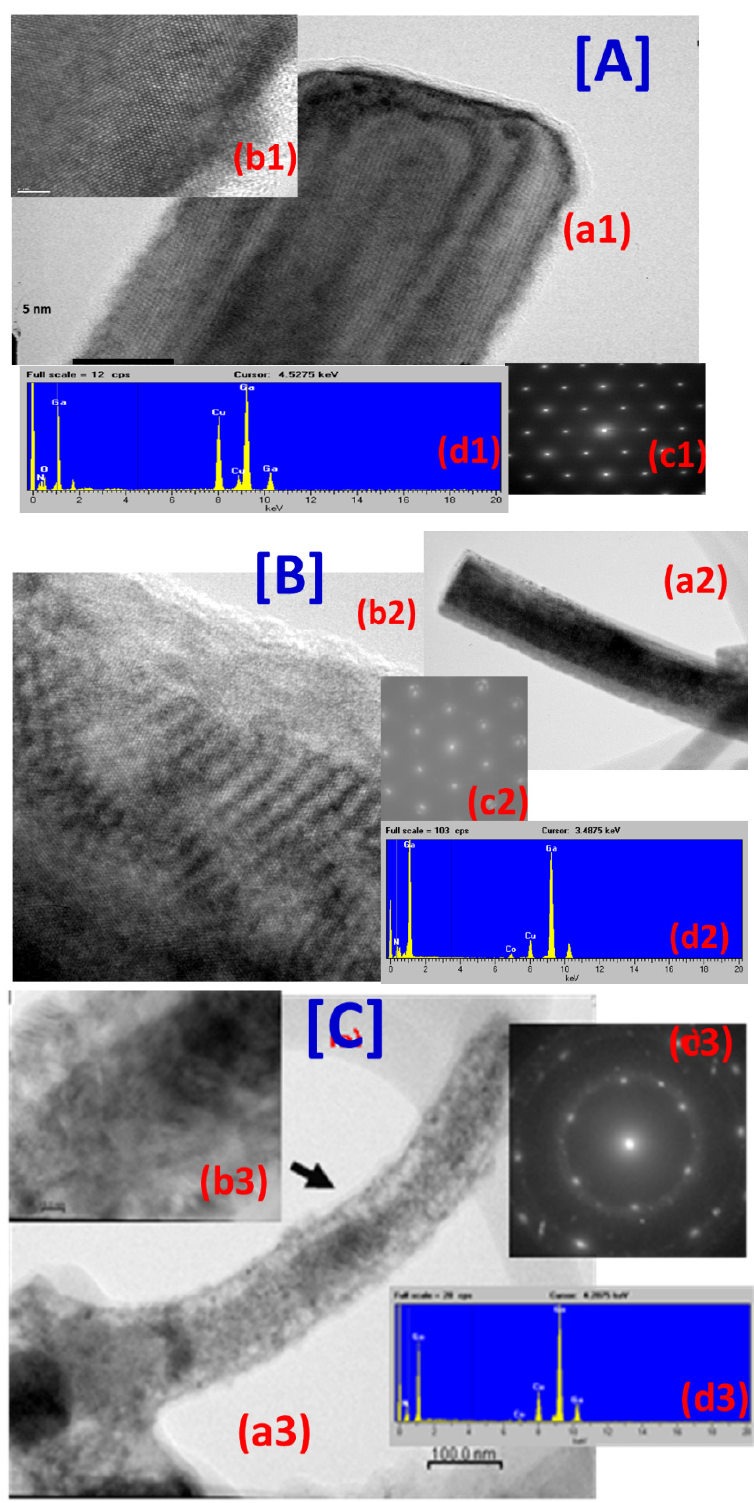
Figure 4. HR-TEM (High-Resolution transmission Electron Microscope) data for three samples of ( A ) as-grown GaN NWs, ( B ) cobalt implanted GaN NWs, and ( C ) annealed Co-GaN NWs; ( a1 – a3 ) show low magnification TEM images, ( b1 – b3 ) show high magnification TEM images, ( c1 – c3 ) for SADP, and ( d1 – d3 ) show EDX data.